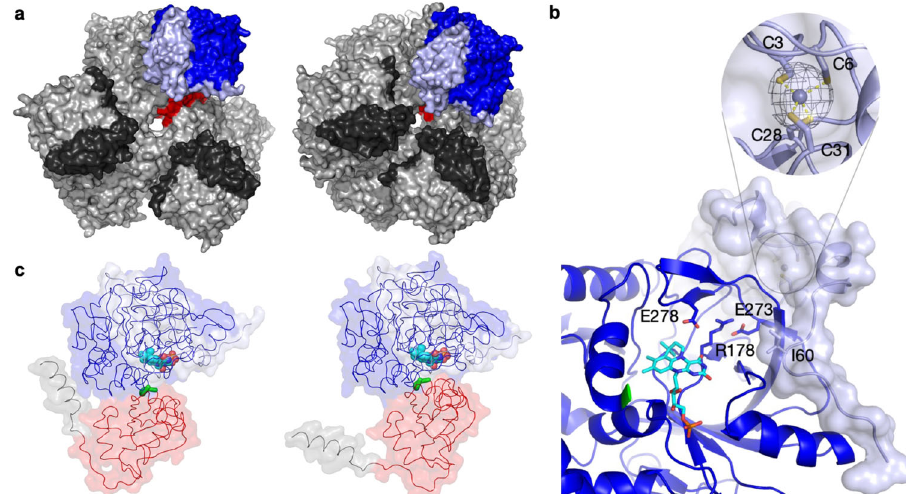
Fig. 3 Structures of VdcCD complexes in open and closed states. a Left – Open hexamer of Sh VdcCD, Right – closed hexamer of Sh VdcCD. A single monomer of Sh VdcC is coloured by domain (red – oligomerisation domain, blue – prFMN binding domain) with Sh VdcD in light blue. All other Sh VdcC in the complex are shown in light grey, with Sh VdcD shown in dark grey. b Interaction of Sh VdcC and Sh VdcD showing the proximity of VdcD binding to the VdcC active site. VdcD interacts with loops containing the key ERE residues which are a key triad for catalysis, VdcD likely serves to maintain the positioning of these residues. prFMN (in cyan) is modelled in the active site based on a structural alignment with holo -Fdc1 (4ZA4). Inset shows the VdcD tetrahedral binding of Zn 2 + by four conserved cysteine residues. Polder map corresponding to Zn 2 + contoured at 5 sigma. c Dyndom analysis reveals a 32° rotation at the T325 and S326 hinge region (in green) connects the open (left) and closed states (right). Other domains coloured as in a , with the C-terminal helix coloured in